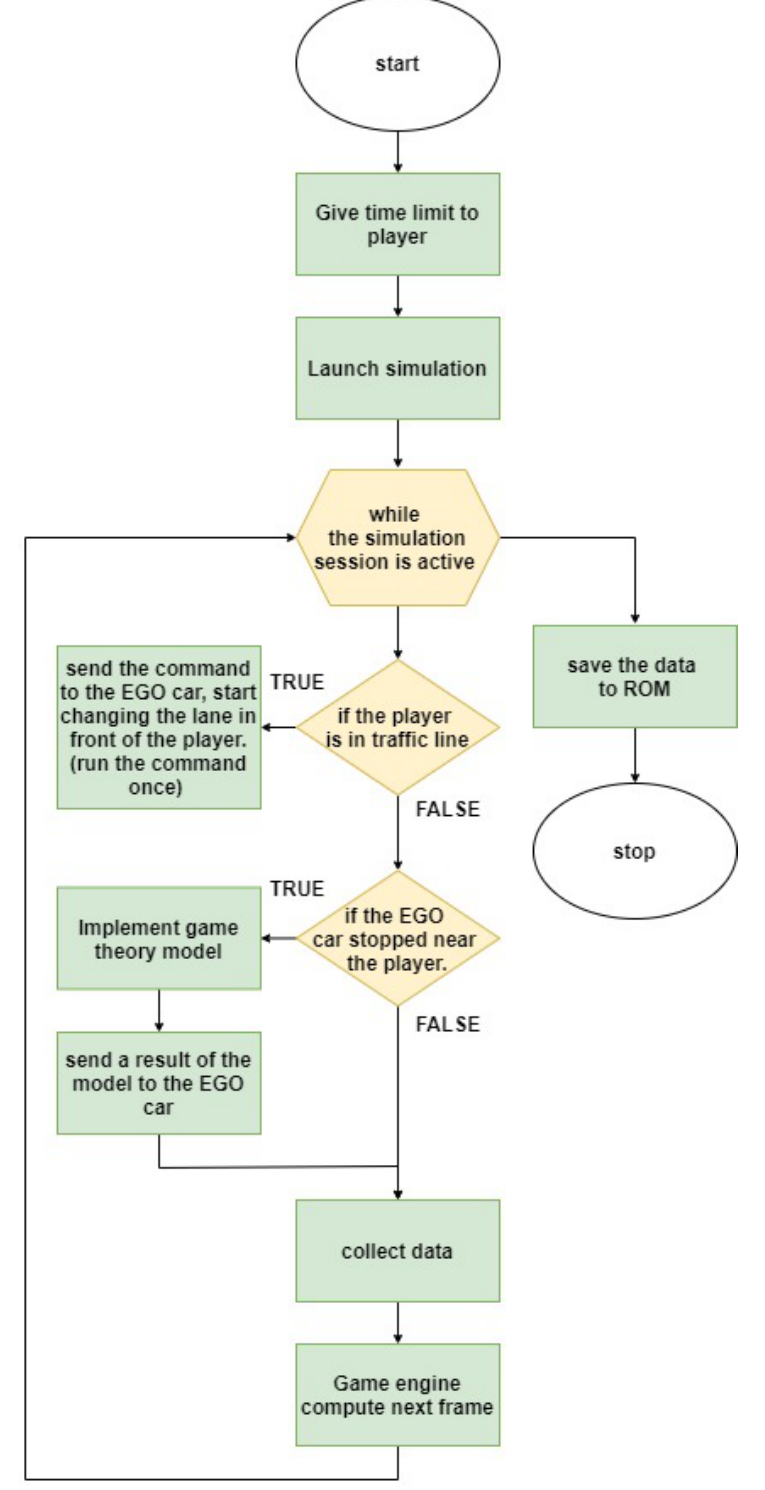
Figure 8. Flow chart describing the validation